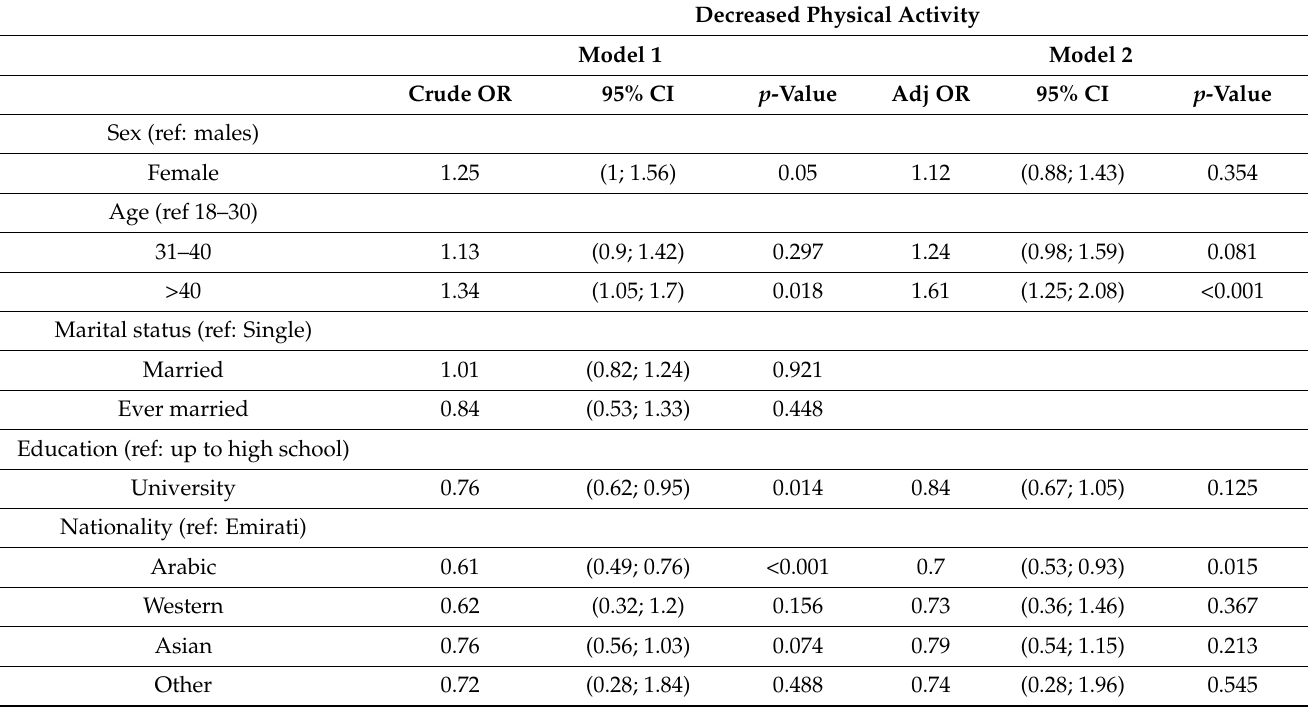
Table A3. Simple and multiple logistic regressions describing the association between decreased physical activity and sociodemographic characteristics in the study population ( n =